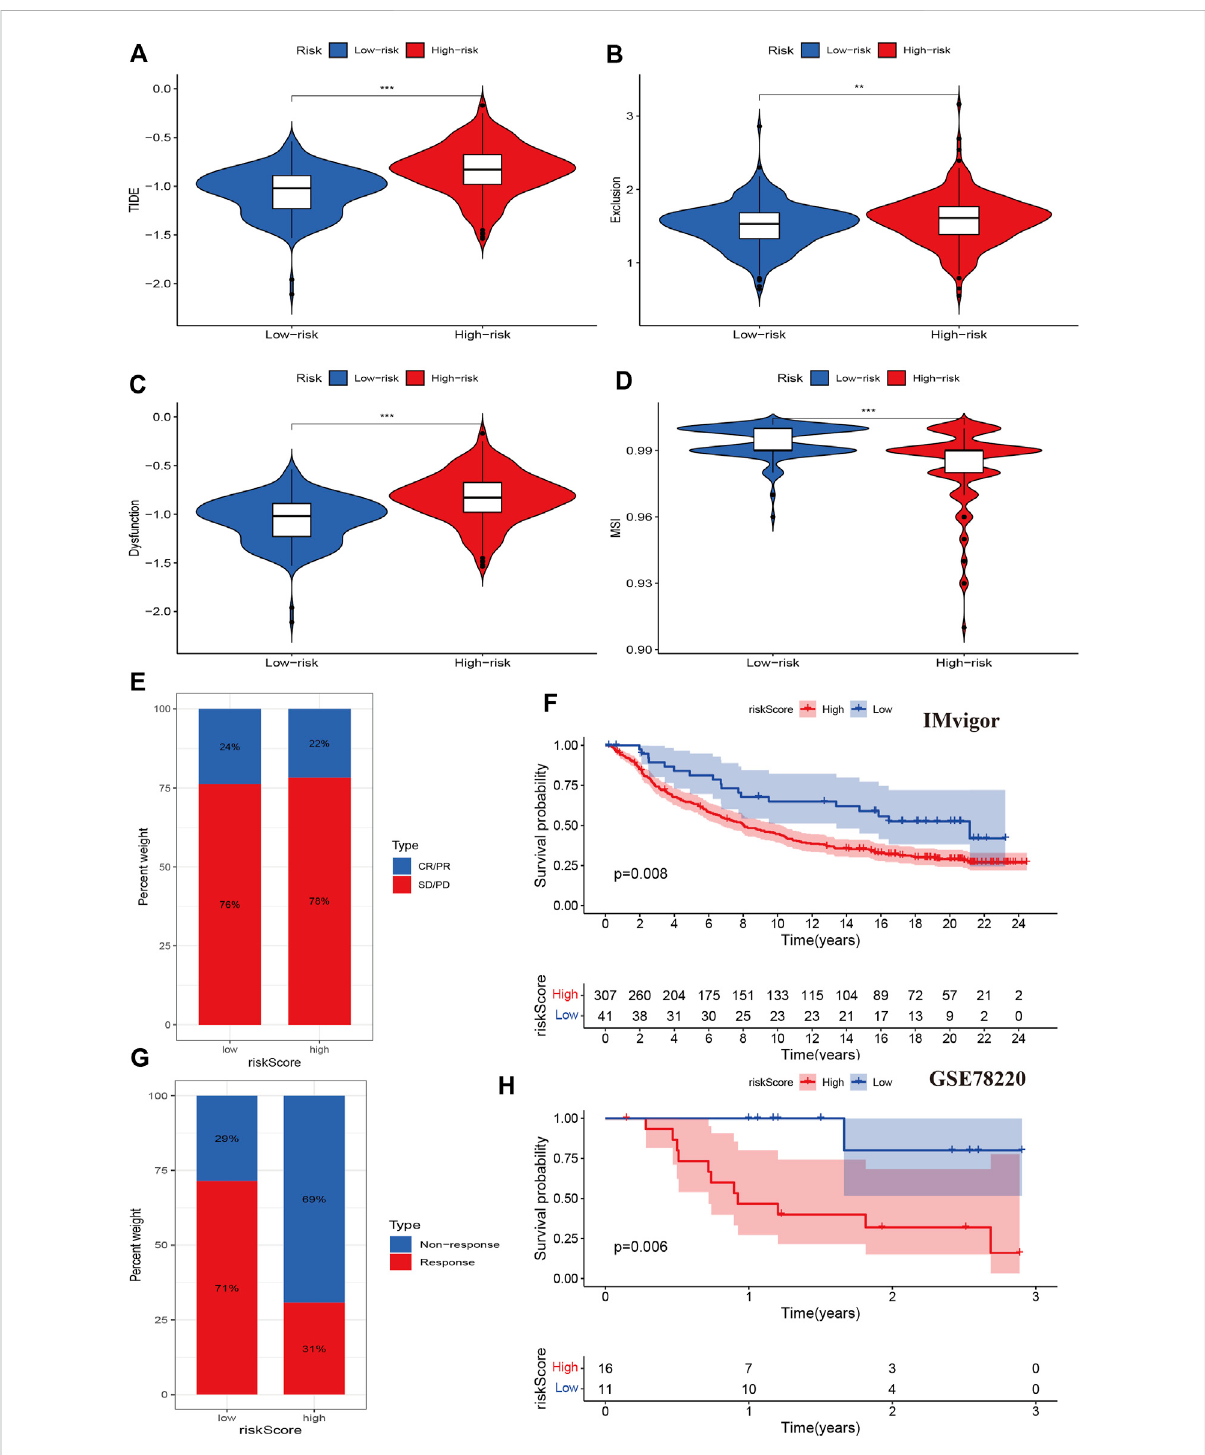
Associations between cuproptosis regulators and immunotherapy. (A – D) : TIDE, exclusion, dysfunction, and MSI levels of different risk groups. (E,F) : The immune response and prognosis comparisons of different risk groups in the IMvigor cohort. (G,H) : The immune response and prognosis comparisons of different risk groups in the GSE78220